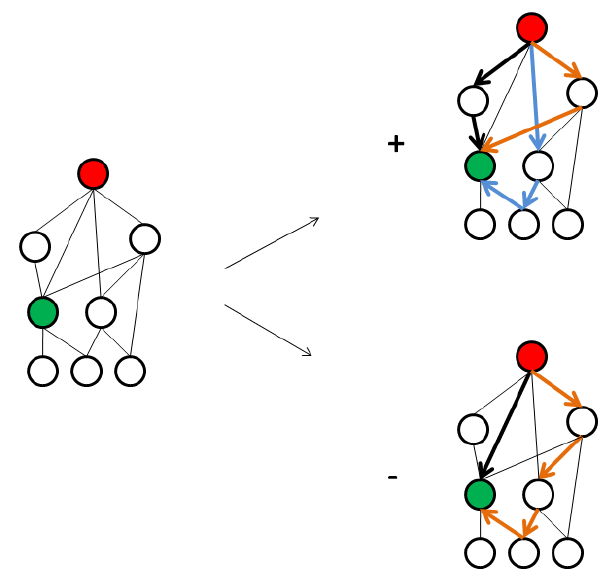
Figure 1. This small interaction network among species illus- trates mixed-sign e ff ects as a typical source of conservation con- flict. Whatever we do with the red species, it will have a positive and negative influence on the green one, both across a variety of indirect pathways. Among the positive e ff ects, we see two trophic cascades (black and orange) and a keystone predation (blue). Nega- tive e ff ects include predation (black) and an unnamed long indirect e ff ect